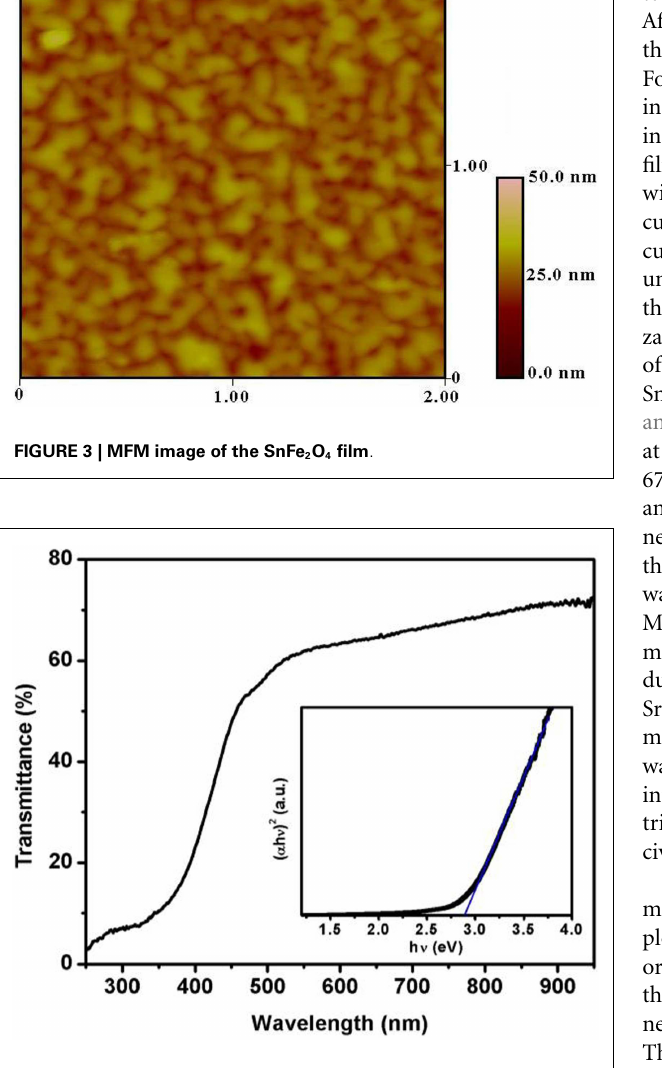
where A and E g are constant and optical bandgap,